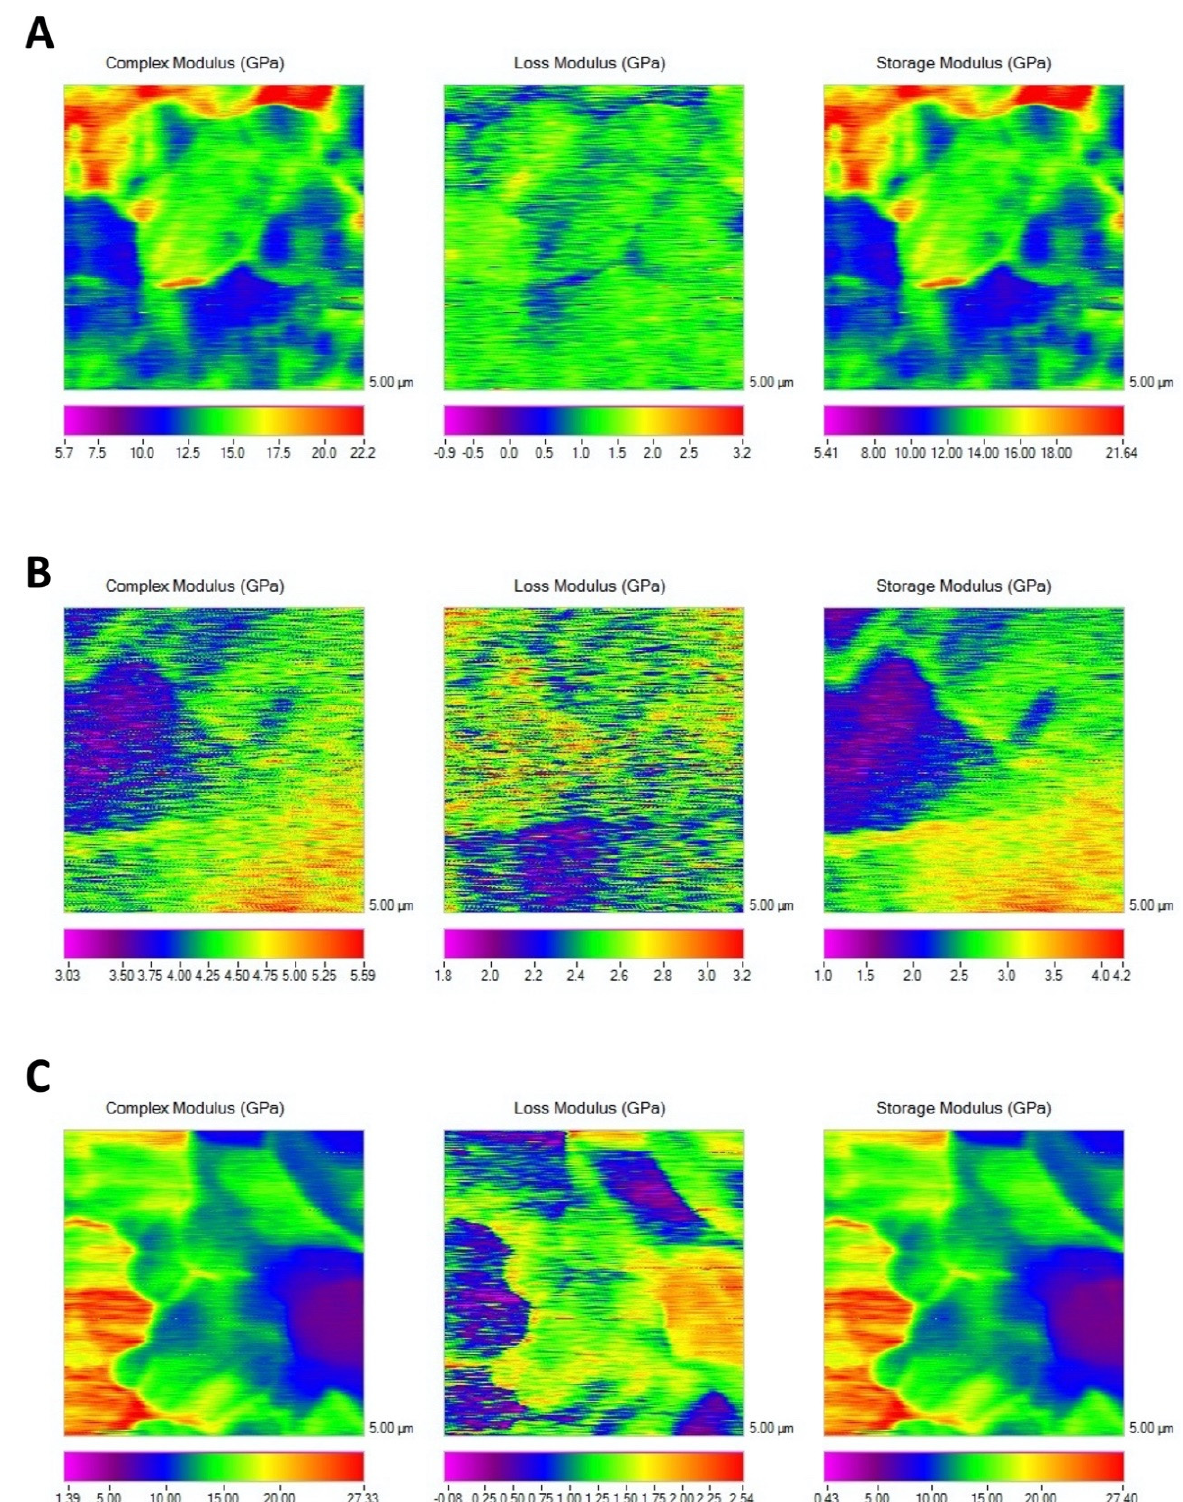
Figure 1. Nano-DMA mapping of the three membranes at the initial time-point. ( A ) Derma, ( B ) Evolution and ( C ) Duo-Teck. Scale bars are in GPa. Scan size is 5 µm × 5 µm.